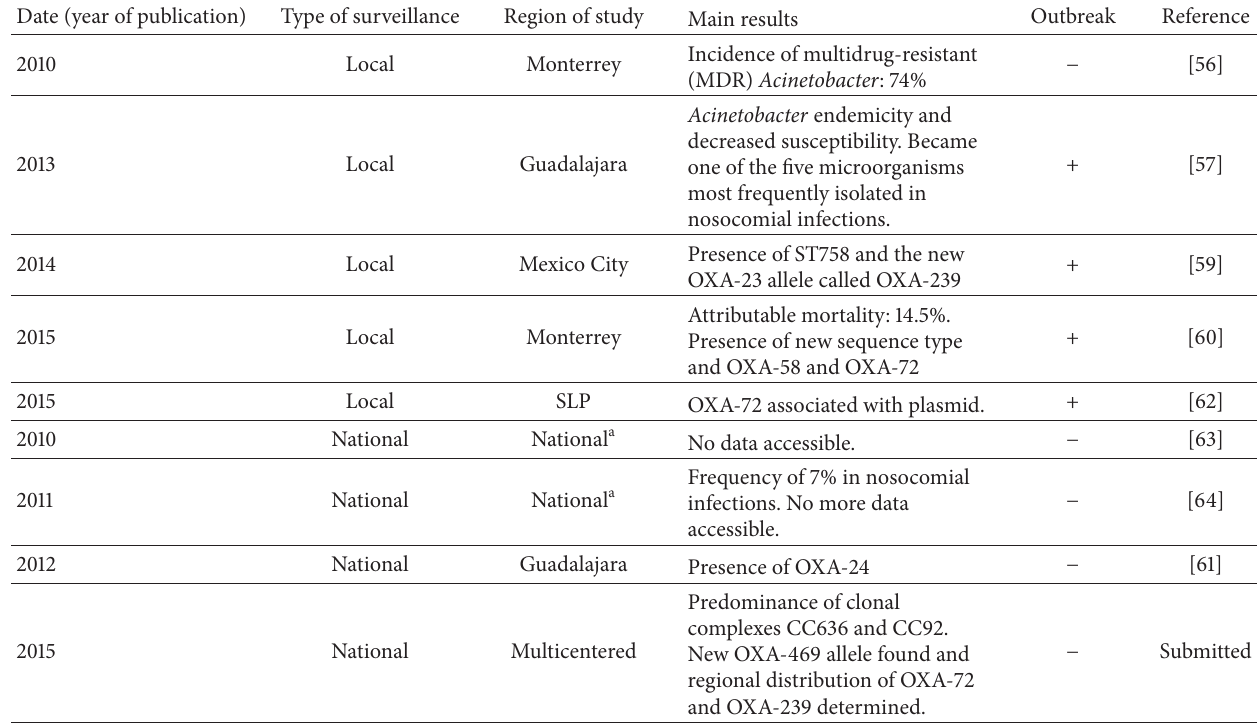
Table 1: Surveillance studies carried out in